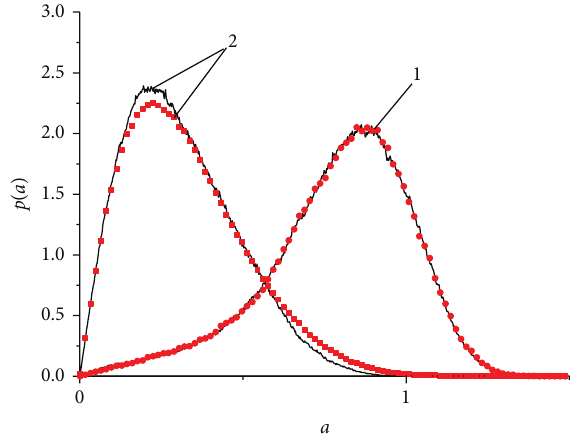
Figure 2: Probability densities of amplitude of the original system (5) and of the slow system (12). Line 1: no fast excitation; line 2: 𝐸 22 ⋅ = 0.8 . Solid lines for the original system (5) and dotted lines for 𝑟 𝑓 the slow system